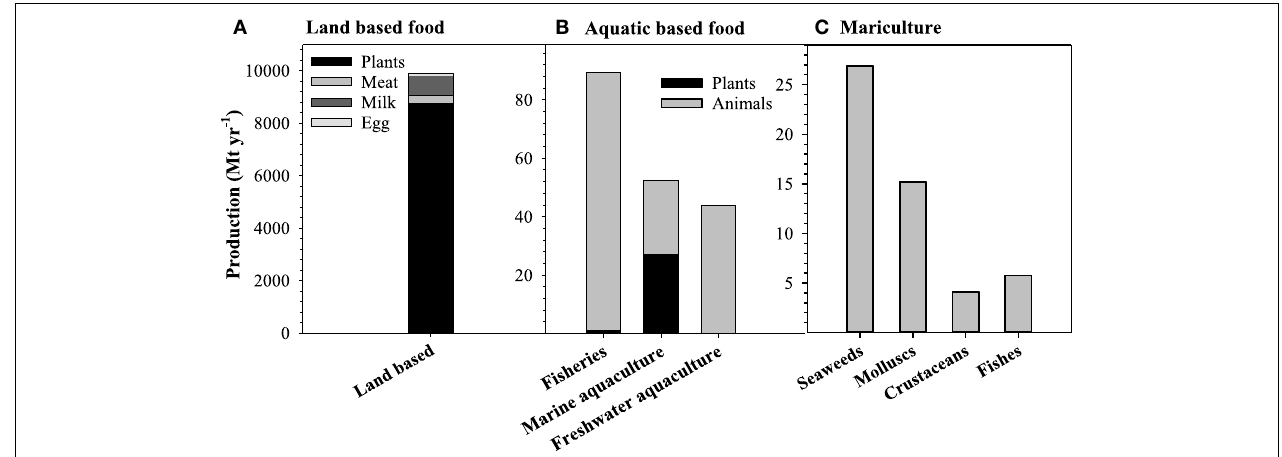
FIGURE 1 | Food production with its main components in agriculture (A), plant and animal production in different aquatic systems (B) and the overall composition of main groups produced in mariculture (C). Note the different scales of the y-axis (Mt, megatons or million